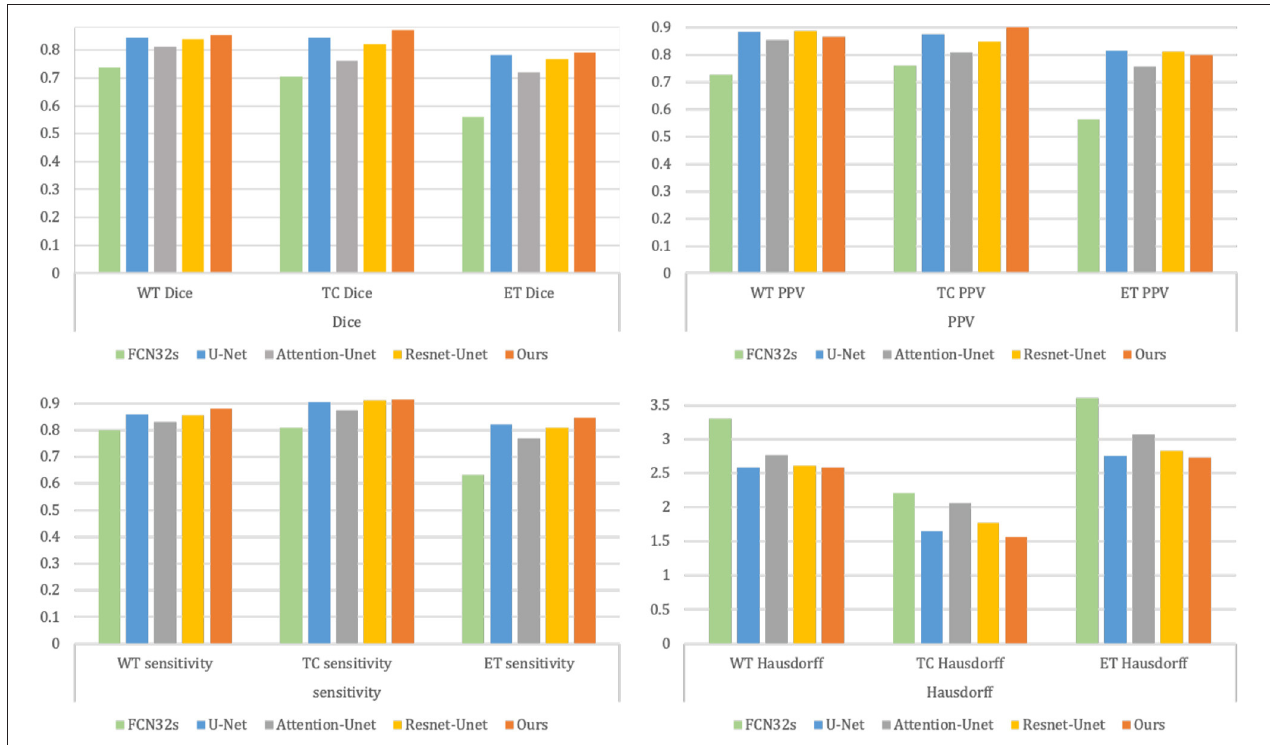
FIGURE 8 | Results comparison between the baseline methods and our proposed methodology.